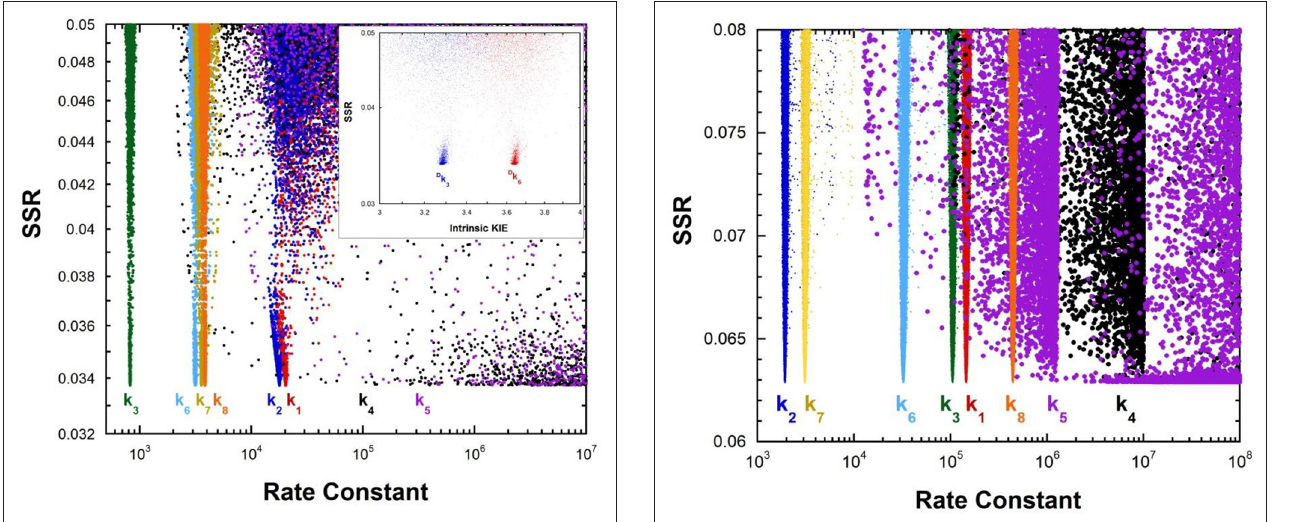
FIGURE 3 | Results of global optimization with fumarase. SSR, sum of squared residuals of the fit to the target function. The figure was generated from ∼ 40,000 independent runs, each starting from randomized sets of rate constants. The fit to the target function is shows significant sensitivity to the values of k 4 and k 5 when they are < 10 7 s − 1 and < 10 8 s − 1 . Therefore, these are the lower limits on the values of these rate constants. the reaction pathway was determined by global